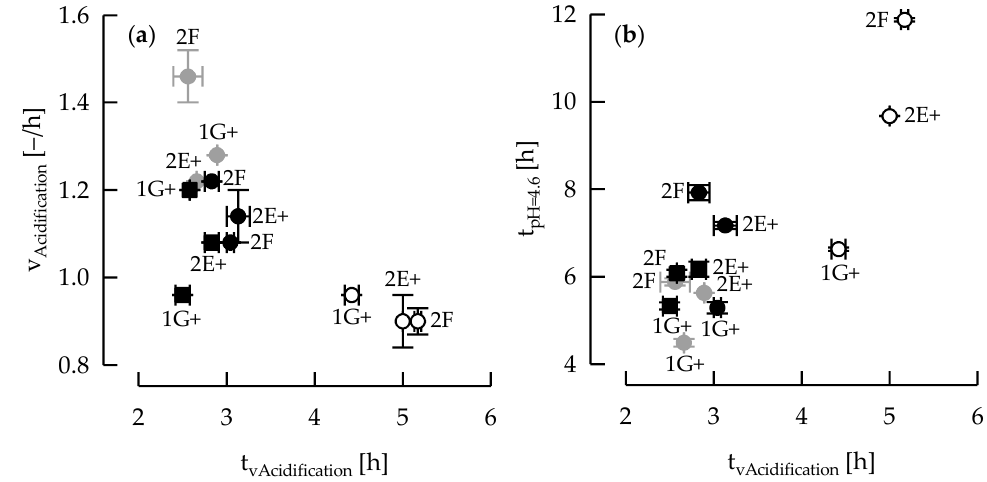
Figure 1. ( a ) Maximum acidification rate (v Acidification ) and ( b ) fermentation time until pH 4.6 (t pH=4.6 ) versus time at v Acidification (t vAcidification ) of milk with a C/WP ratio of 4.0:1 after fermentation with low activity starters at 37 °C (white circles). Black circles, similar conditions but fermentation with high-activity starters. Black squares, fermentation with high-activity starters at 42 °C. Grey circles, fermentation of milk with a C/WP ratio of 1.5:1 with high-activity starters at 37 °C.